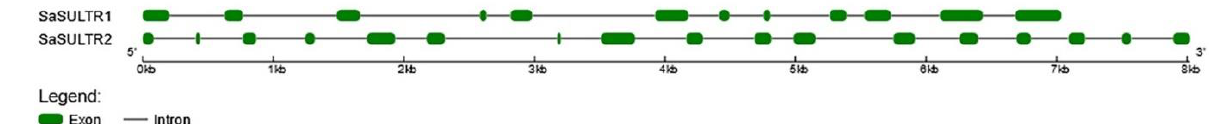
Figure 1. Structures of two SaSULTRs genes.